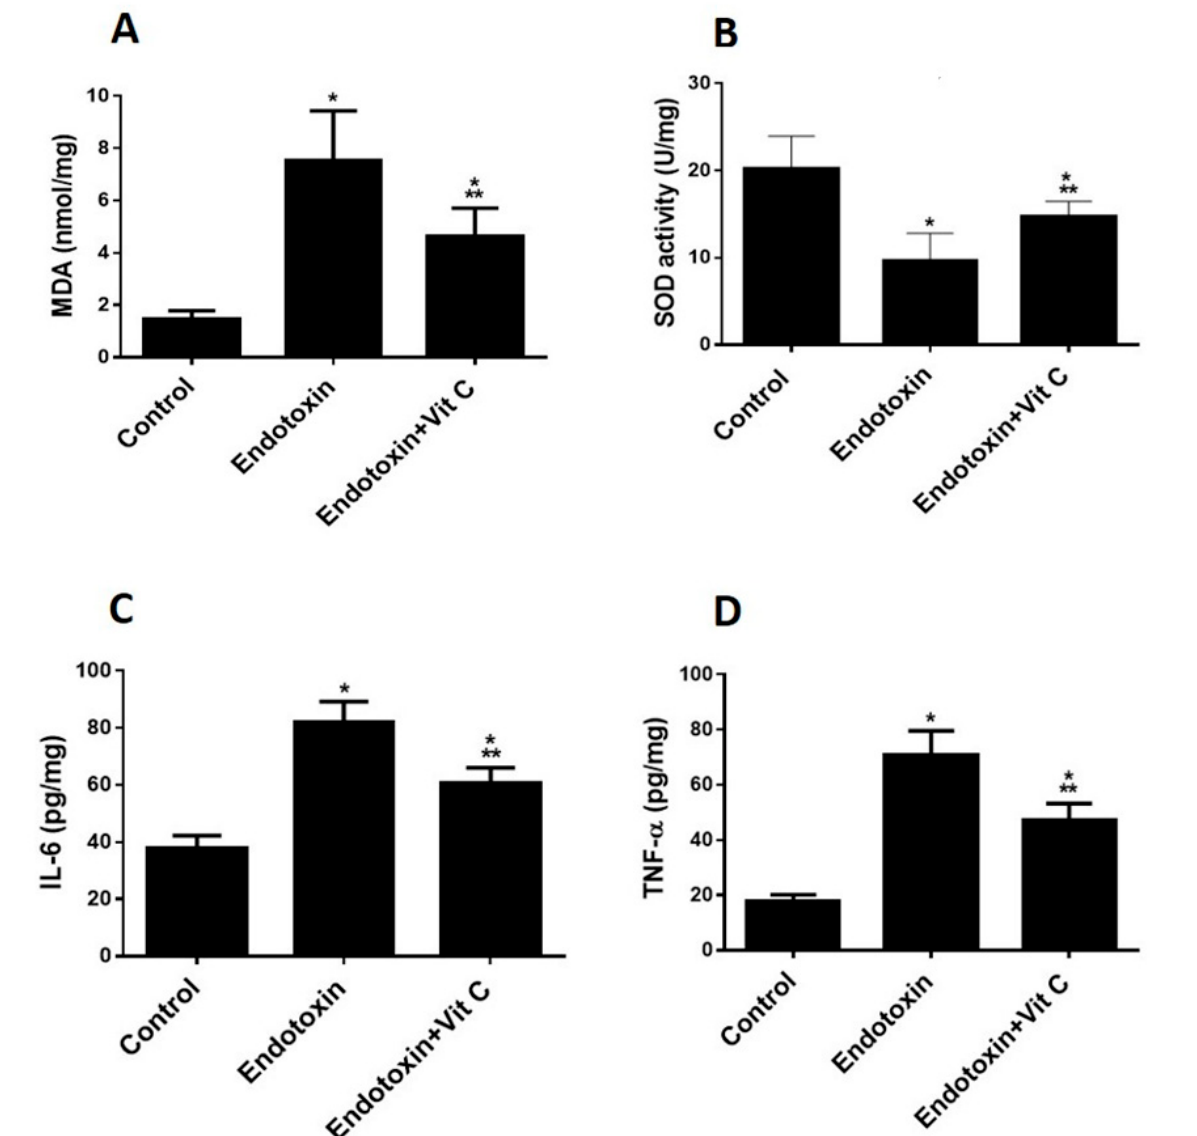
Figure 1. Biochemical parameters (Oxidative stress and proinflammatory biomarkers) of all groups. ( A , B ): Vit C protects against endotoxin-induced oxidative stress and decreases biomarkers of oxidative stress (MDA ( A ) and SOD ( B )) in heart homogenates of the three studied groups. The findings are the mean ( ± SD), n = 6. * p < 0.05 when compared to the controls, *** p < 0.05 in contrast to endotoxin group. ( C , D ): Vit C protects against endotoxin-induced inflammation and decreases the pro-inflammatory biomarkers (IL-6 ( C ) TNF- α ( D )) in heart homogenates of the three studded groups. The findings are the mean ( ± SD), n = 6. * p < 0.05 when compared to the controls, *** p < 0.05 in contrast to endotoxin group.